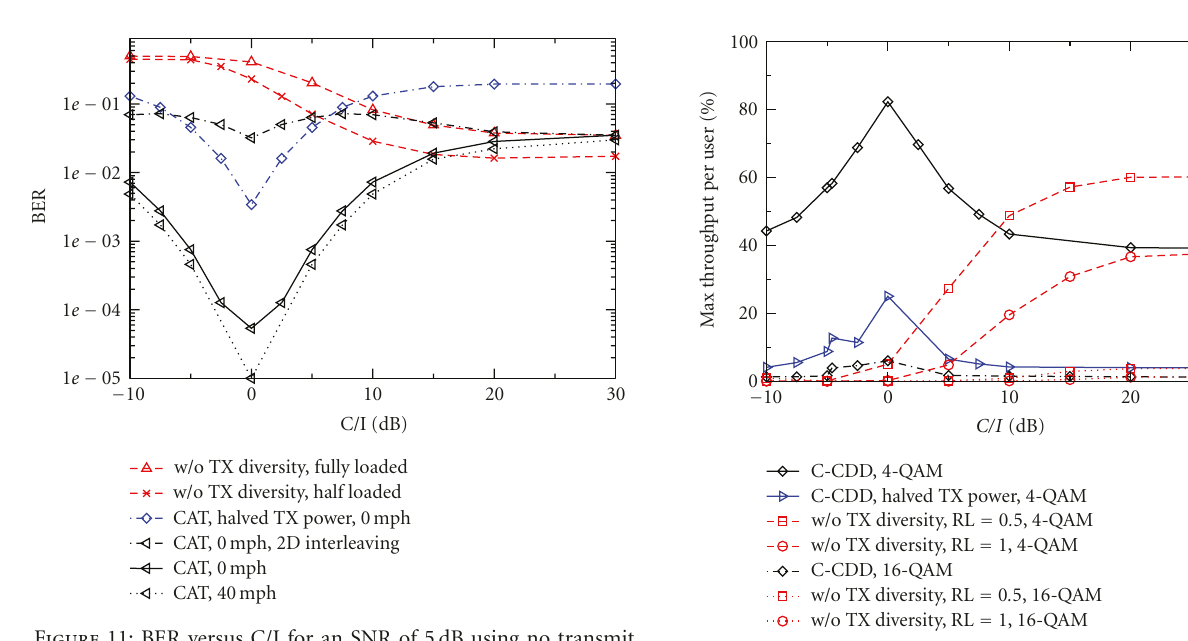
Figure 13: Throughput per user for 4-QAM versus C/I using no transmit diversity or C-CDD with full and halved transmit